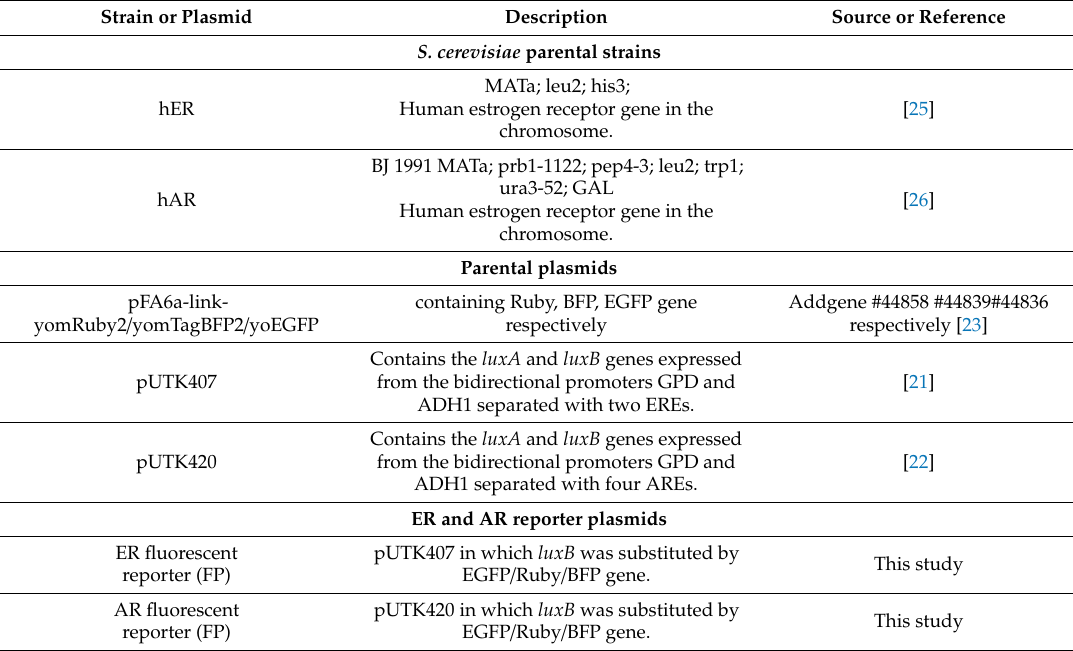
Figure 1. Schematic design of the hER-FP ( A ) and hAR-FP ( B ) plasmids used in this study for the detection of estrogenic and androgenic activity, respectively. Plasmid hER-FP ( A ), derived from plasmid pUTK407 (21), contains two copies of the human estrogen response element (ERE). Plasmid hAR-FP ( B ), derived from plasmid pUTK420 (22), contains four copies of the human androgen response element (ARE). Upon binding of a receptor–ligand complex to its respective response element, a hairpin structure is released and activation of the constitutive GPD and ADH1 promoter is enabled, resulting in transcription of luxA and fluorescent genes (FP), either EGFP, BFP, or Ruby. Table 1. Saccharomyces cerevisiae strains and plasmids used in this study.